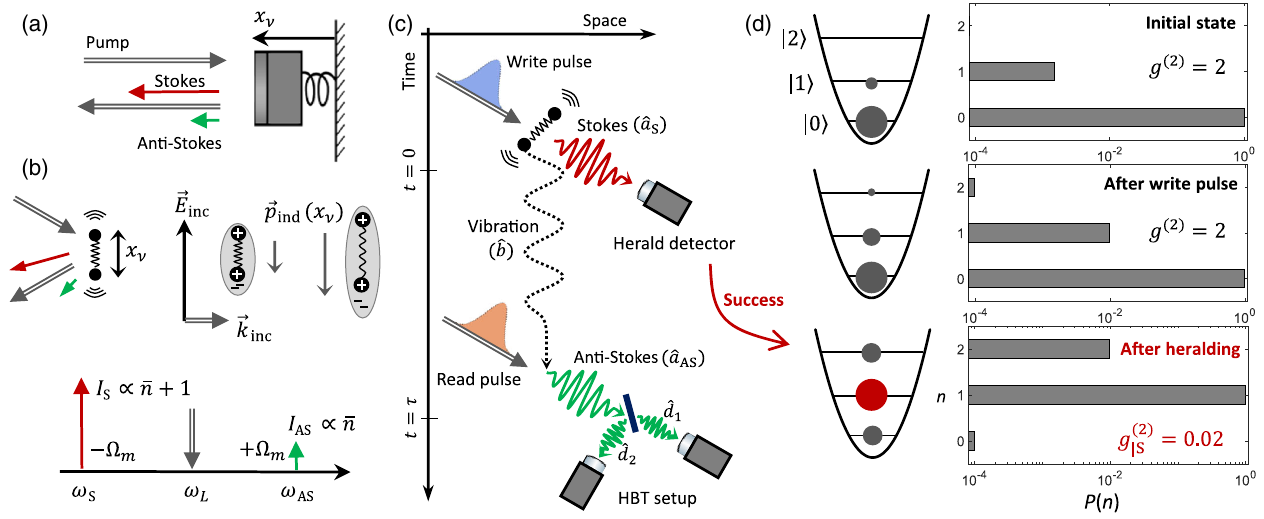
FIG. 1. Concept of the experiment. (a) When monochromatic light reflects from an oscillating mirror, it acquires two Raman sidebands due to phase modulation (to first order in interaction strength). (b) When light interacts with a polarizable oscillator, whose induced polarization ⃗ p depends on its internal coordinate x ν , it undergoes a phase modulation at the oscillator frequency, leading to the ind appearance of Stokes and anti-Stokes Raman sidebands in the scattered light. The anti-Stokes/Stokes intensity ratio is proportional to ¯ n= ð ¯ n þ 1 Þ , where ¯ n is the mean excitation number (or occupancy) of the vibrational mode. (c) Time evolution of a single repetition of the experiment showing the interaction of the write pulse, the subsequent detection of Stokes photons for heralding, and the final read pulse followed by measurement of two-photon correlation in the emitted anti-Stokes light. (d) Evolution of the probability P ð n Þ of finding the vibrational mode in the n th energy eigenstate during the different steps. The system is initially in a thermal state with ¯ n ¼ 1 . 5 × 10 − 3 (for a mode frequency of 40 THz at 295 K). After the write pulse, the marginal state of the vibration is also thermal with ¯ n ¼ ½ p= ð 1 − p Þ(cid:2) ¼ 10 − 2 in this example (here p is the interaction probability). Finally, after heralding, the distribution becomes peaked at n ¼ 1 . The residual vacuum component is due to detection noise. For each distribution, we give the corresponding value of the vibrational mode ’ s intensity correlation function g ð 2 Þ